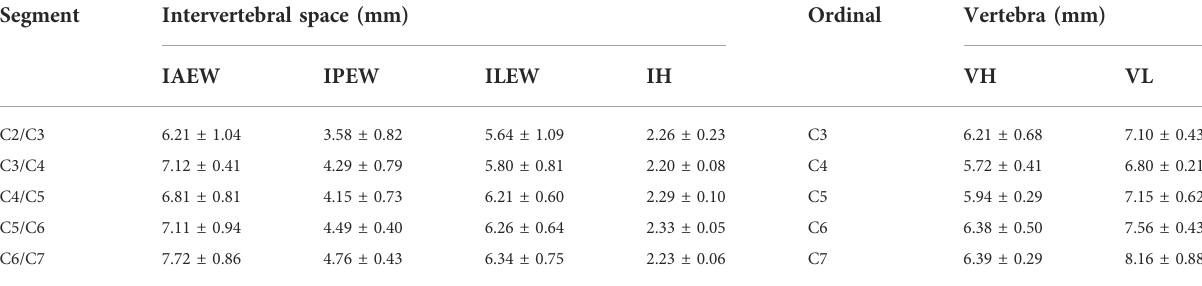
TABLE 1 Cynomolgus monkey cervical spine anatomical measurements.